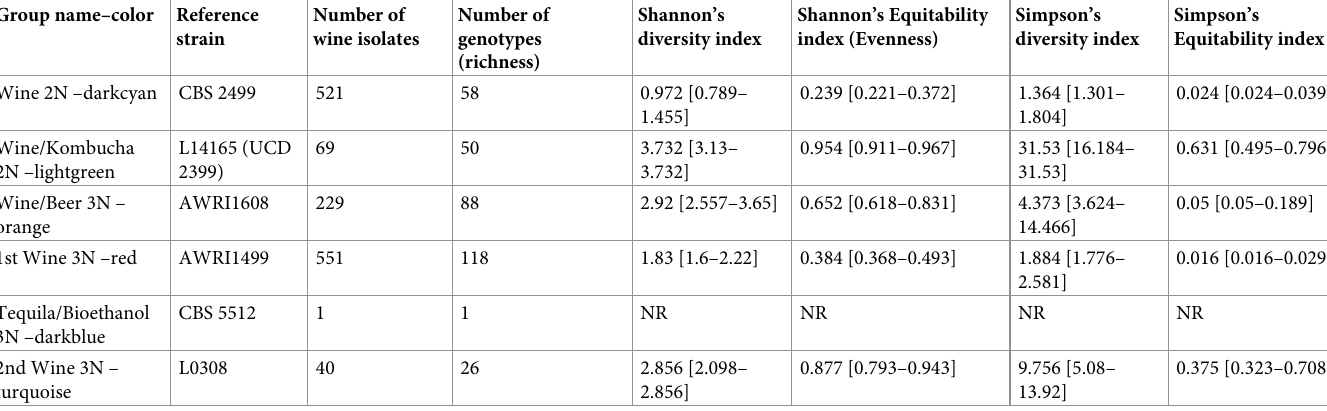
Table 1. Distribution of 1411 wine isolates of Brettanomyces bruxellensis and main diversity parameters. Group name–color Reference